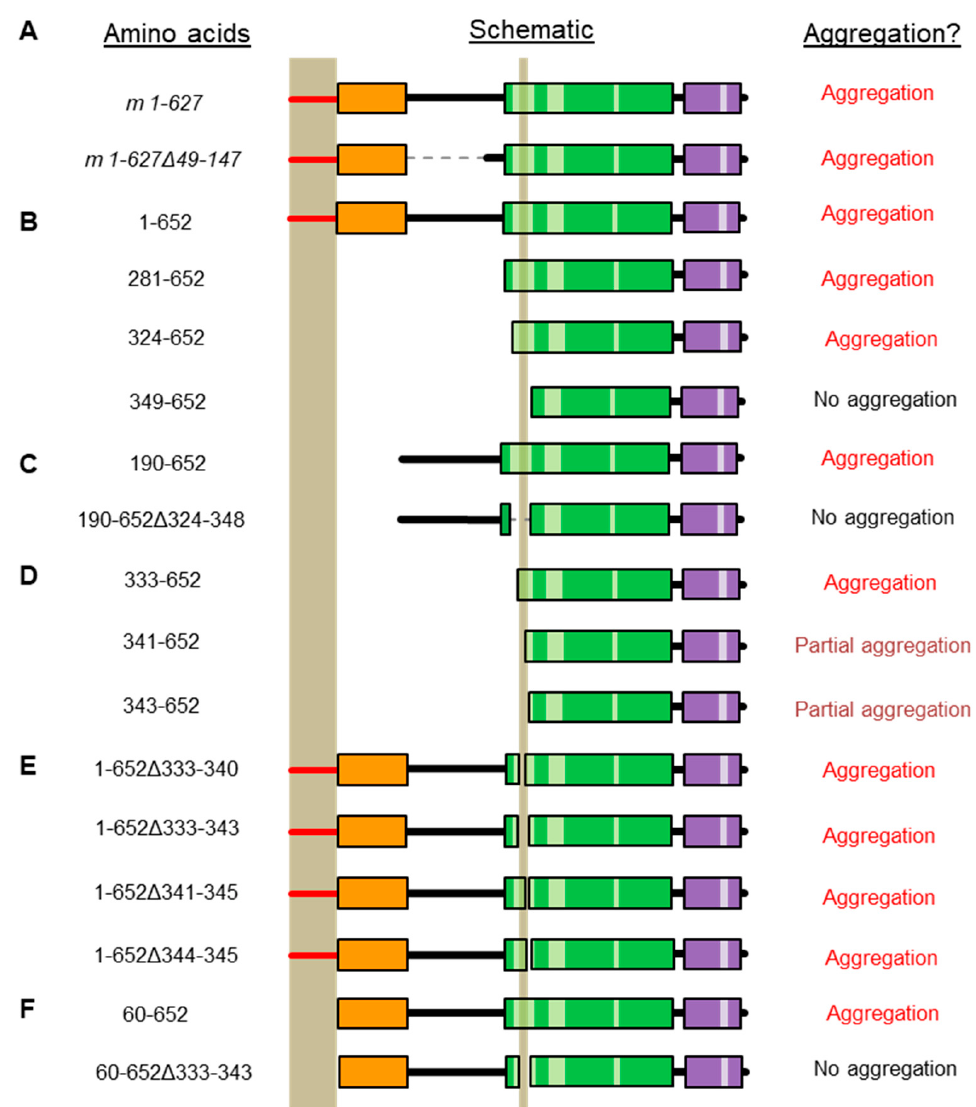
Figure 6. Selected TRIOBP-1 deletion constructs that have been tested for aggregation in SH-SY5Y cells and their resulting aggregation status. The domain structure of TRIOBP-1 is labeled according to Figure 1. The two putative aggregation domains are indicated as vertical bars. All vectors encode human TRIOBP-1 unless noted. ( A ) Mouse Triobp-1 constructs show the PH domain to be expendable for aggregation [9]. ( B ) N-terminal deletions of TRIOBP-1 demonstrate AA 324-328 to be essential for aggregation [15]. ( C ) Deletion of AA 324-348 in a vector lacking the optional N-terminal region and PH domain also blocks aggregation [15]. ( D ) Further N-terminally truncated vectors narrow the critical region to AA 333-340 (see Figure 3). ( E ) Deletions of the aggregation critical region in otherwise full-length TRIOBP-1 does not block aggregation (see Figure 4). ( F ) Double deletion of the N-terminal optionally translated region and the central aggregation critical region abolishes aggregation (see Figure